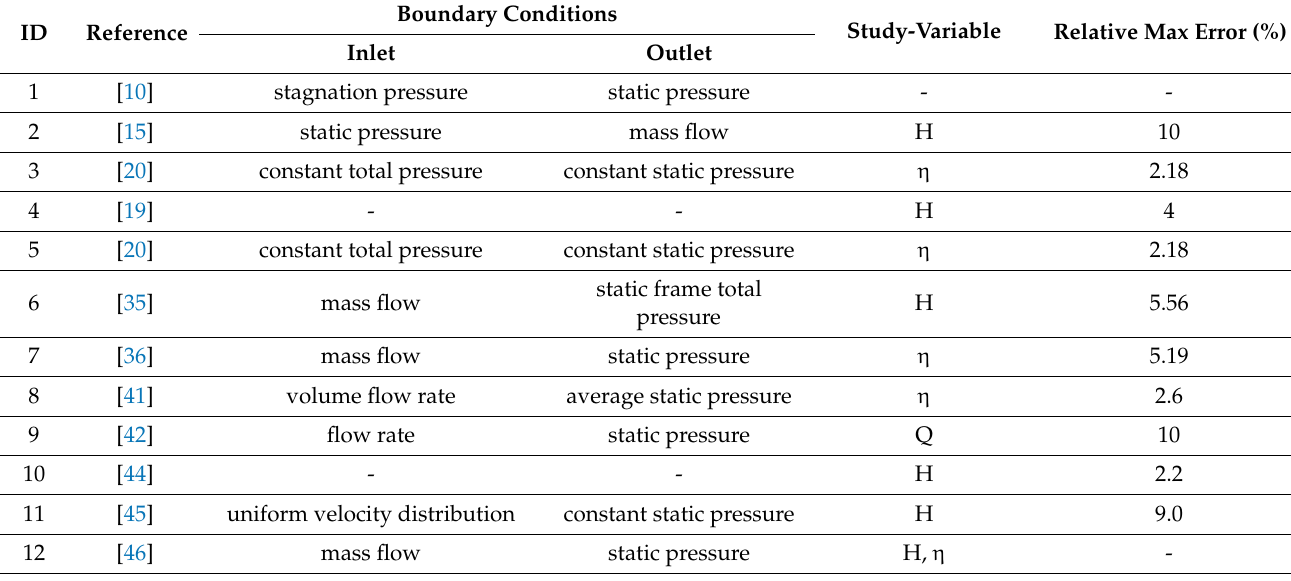
Table 2. Boundary conditions, study variable and reported/calculated error in radial pumps with fixed speed